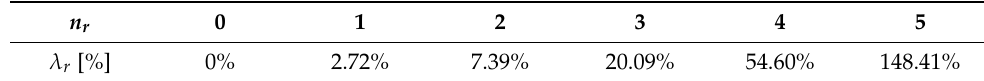
Table 1. Transfer mode impact for a =